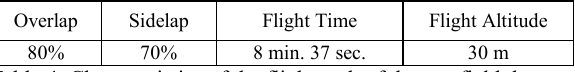
Table 4. Characteristics of the flight path of the test field